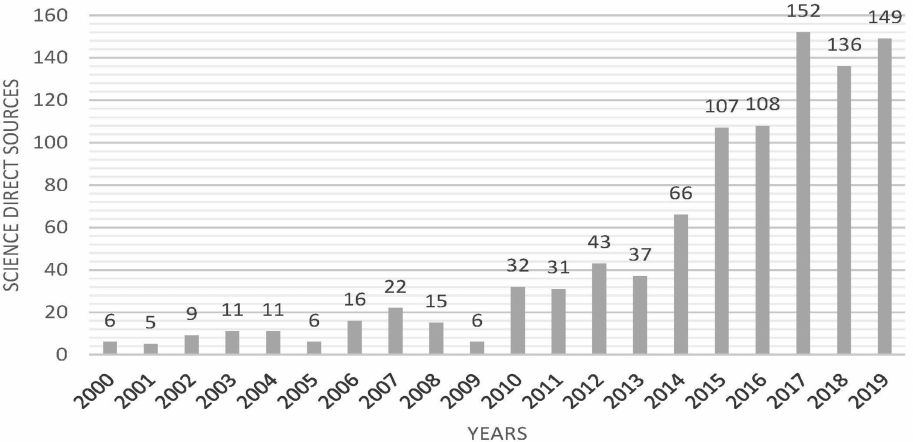
Figure 1. Results retrieved from the ScienceDirect search engine (keys: publication after 1999; text string “outdoor thermal comfort” in paper abstract and / or title).